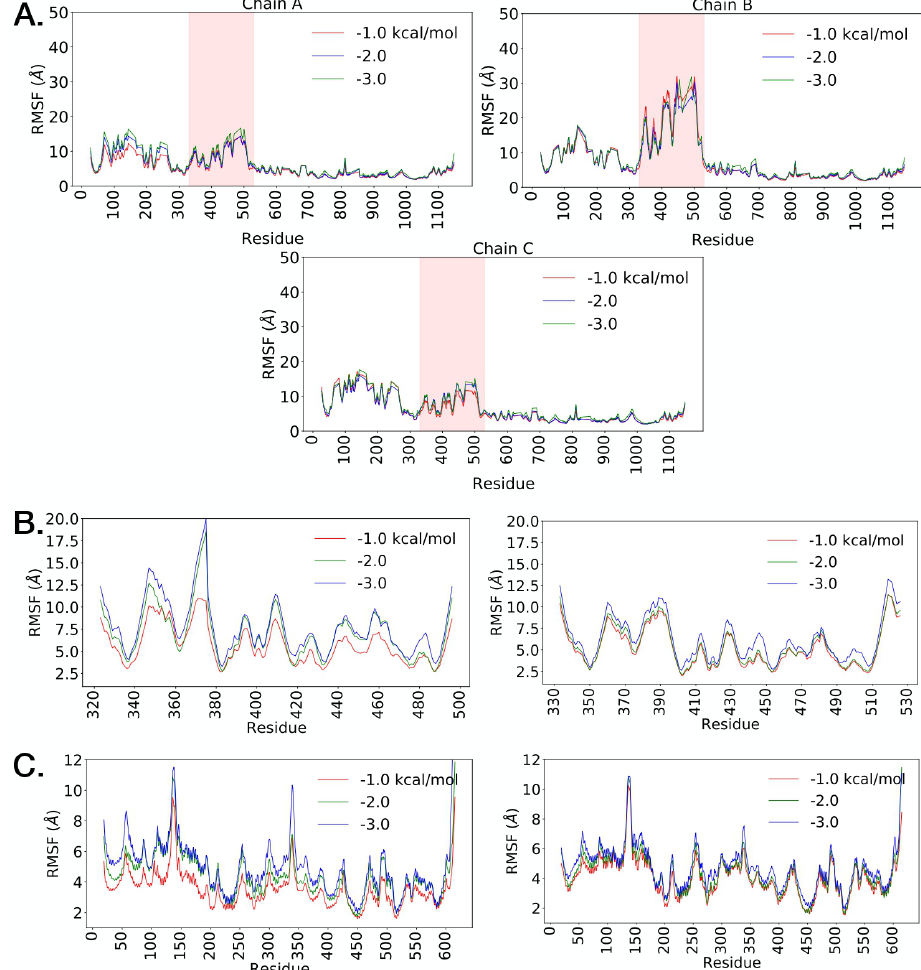
Figure 7. Conformational dynamics analysis using FRODAN method: ( A ) Backbone RMSF profiles SARS-CoV-2 Spike protein with RBD shown in pink. ( B ) RMSF of the RBD domain in the complex with hACE2 (left SARS-CoV-1, right SARS-CoV-2). ( C ) RMSF of the hACE2 domain in the complex (left SARS-CoV-1, right